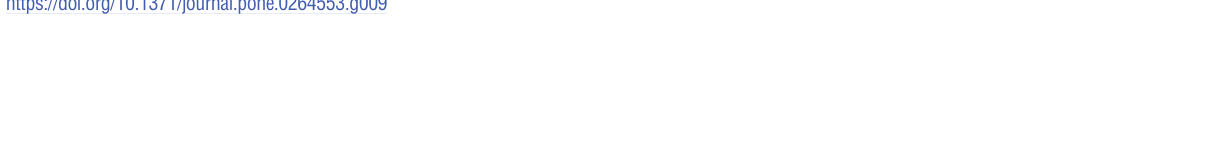
PLOS ONE | https://doi.org/10.1371/journal.pone.0264553 March 4,